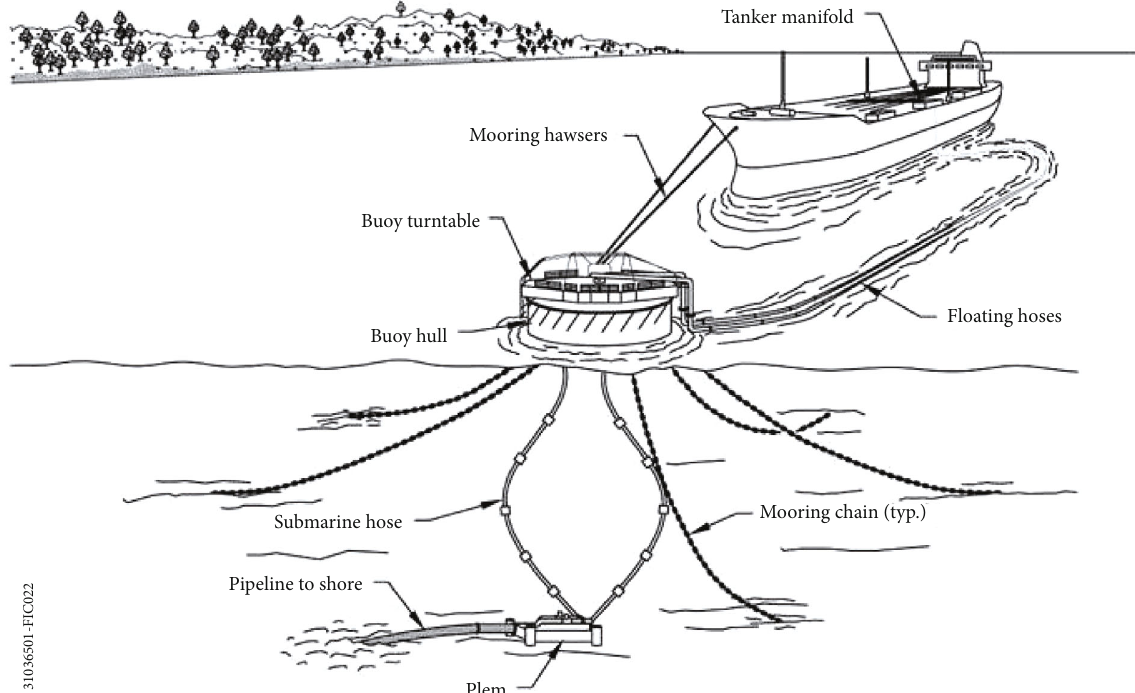
Figure 1: Schematic of a typical catenary anchor leg mooring (CALM)